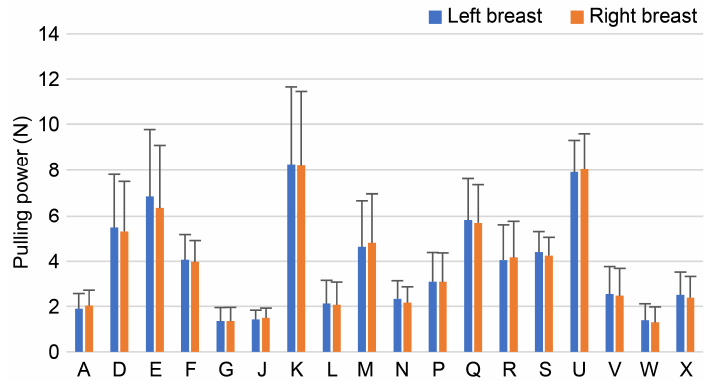
Figure 7. Pull-up distance results.